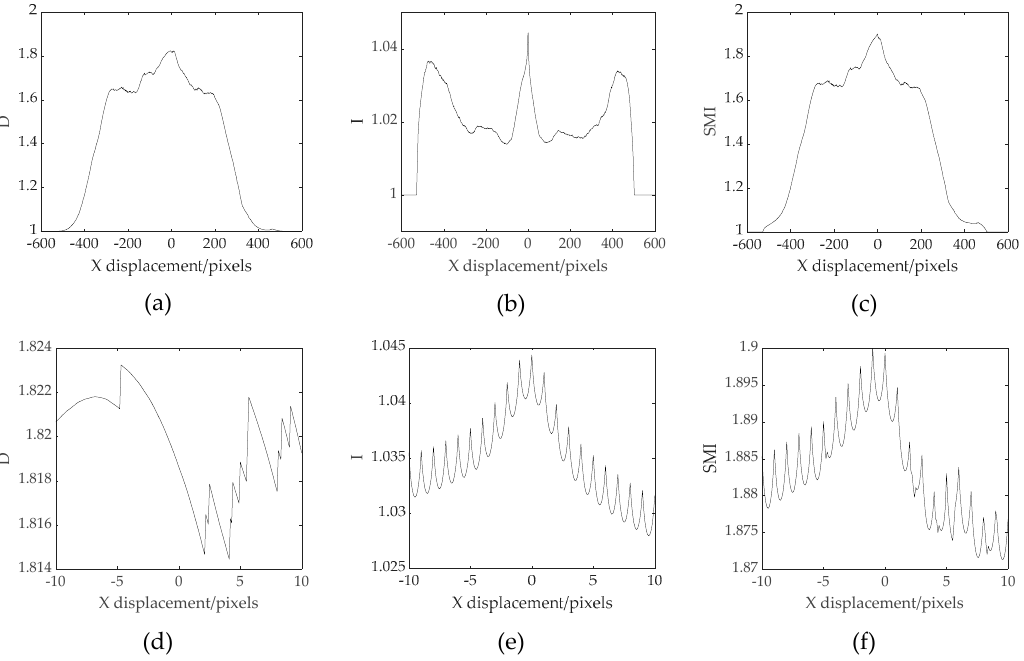
Figure 8. D, I, and SMI values under different horizontal translations between the manually registered images in Figure 6b. (a), (b), and (c) are the D, I, and SMI values when the horizontal displacement is between [-600 600] at pixel intervals; (d), (e), and (f) are the D, I, and SMI values when the horizontal displacement is between [-10 10] at 0.1 pixel intervals.